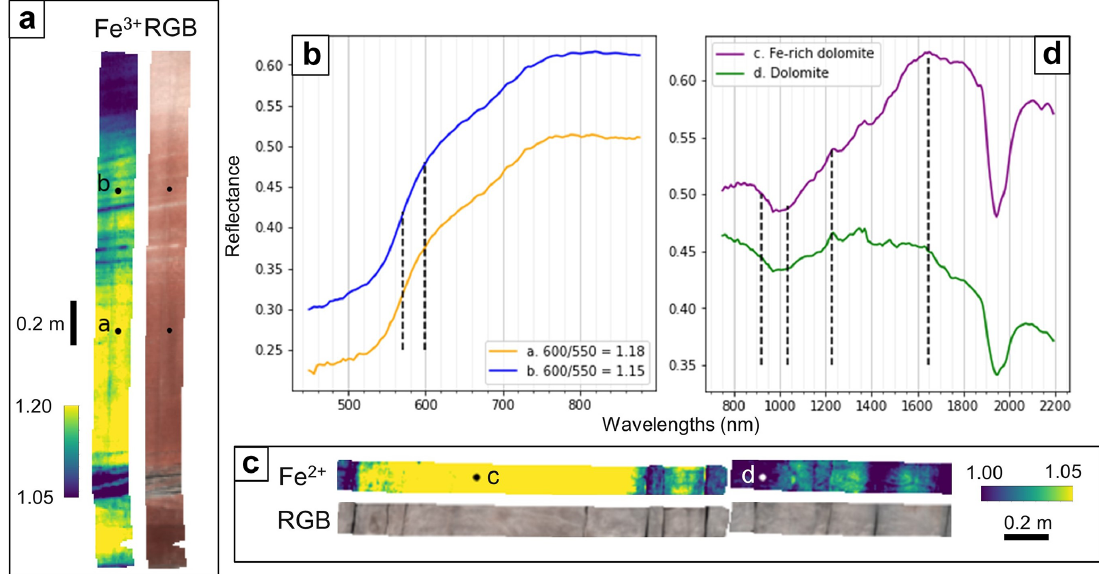
Figure 12. (b) Average (5 × 5 pixels) spectrum at locations a and b in (a) of hematite-bearing sandstones in drill core 131 (987.2–988.2m depth). (d) Average (5 × 5 pixels) spectrum at locations c and d in (c) of dolomite in drill core 131 (976.75–978.20m depth from left to right). Vertical lines in (b) and (d) highlight the bands used to calculate the Fe 3 + index and the Fe 2 + index respectively.